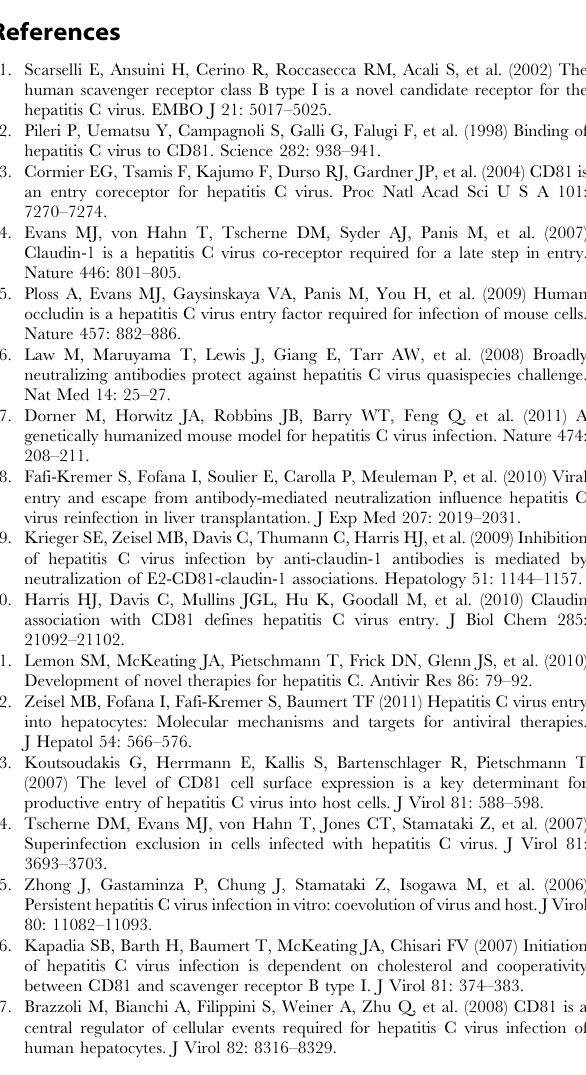
Table S1 Estimates of model parameters obtained from fits of model predictions to the data in Figs. 3B and S4A. 95% confidence intervals are indicated in brackets. Table S2 Estimates of model parameters obtained from fits of model predictions to the data in Figs. 3C and S4B. 95% confidence intervals are indicated in